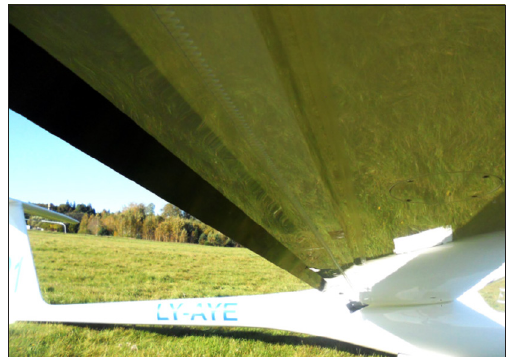
Fig. 14. The miniflaps are in the extended position with the precurved mylar seal coating them at the underside of the wing’s trailing edge (Photo: P. Lauk)